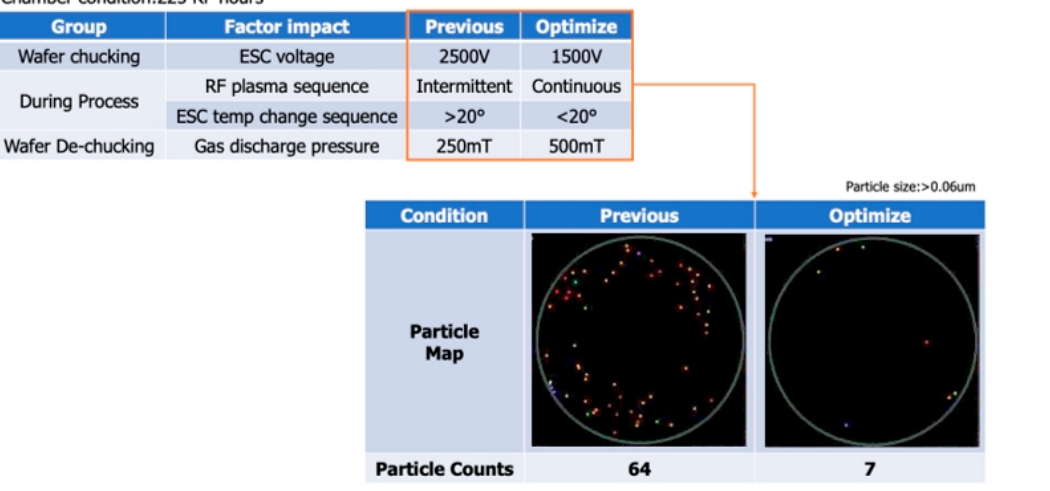
Figure 23. Particle distribution results by previous/optimized setting condition.